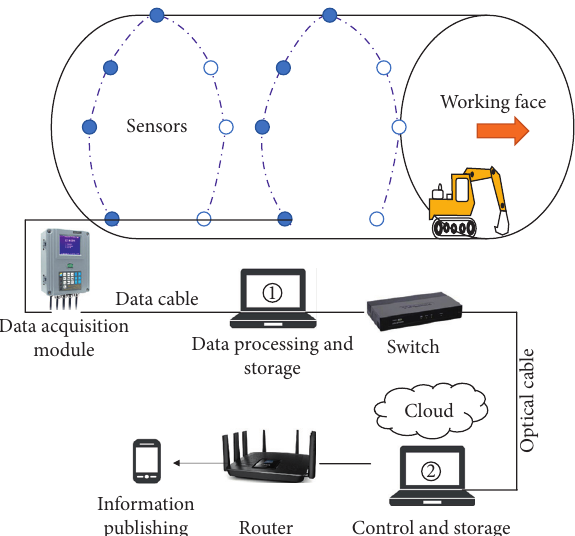
Figure 5: Transmission network of the intelligent monitoring